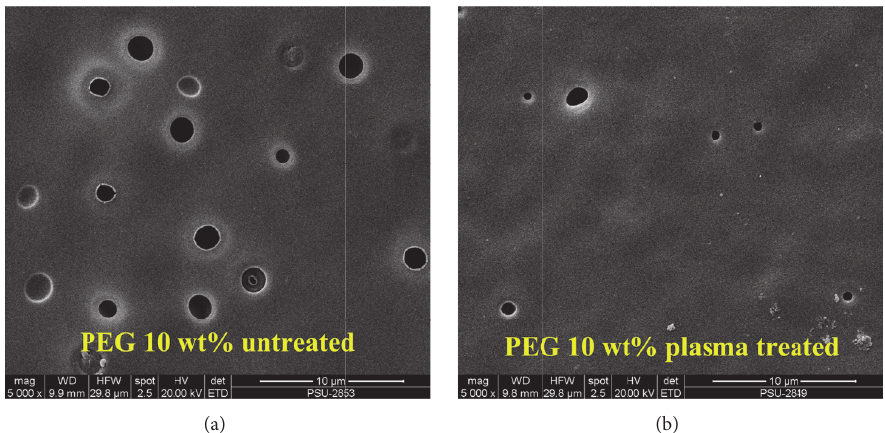
Figure 9: SEM micrographs of top skin layers of PSF/PEG 10wt% membranes, untreated (a) and Ar-plasma treated at a discharge power and treatment time of 15 W and 5min (b), respectively.